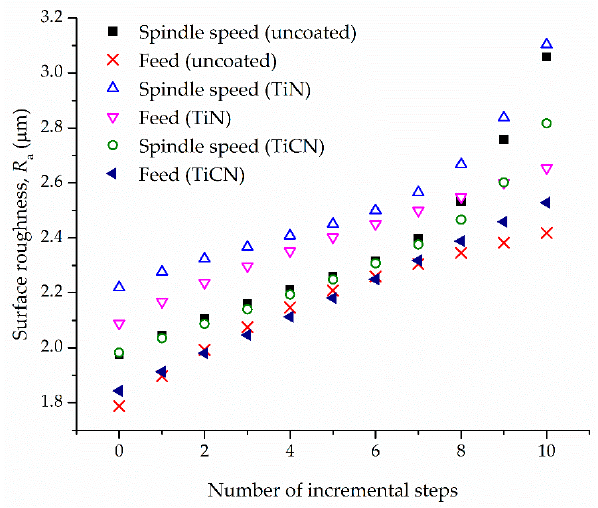
Figure 11. Sensitivity analysis.